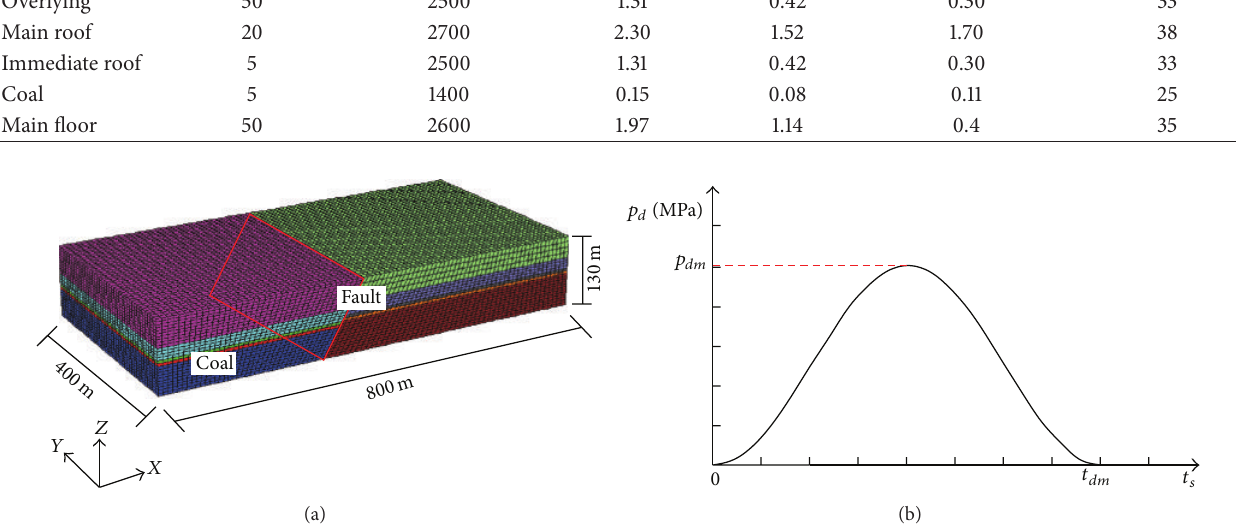
Figure 2: Basic model and fault location analyzed under combined static and dynamic loading. (a) Model setup. (b) The waveform of dynamic stress 𝑝 𝑑 (𝑡) with amplitude of 𝑝 𝑑𝑚 and duration of 𝑡 𝑑𝑚 .